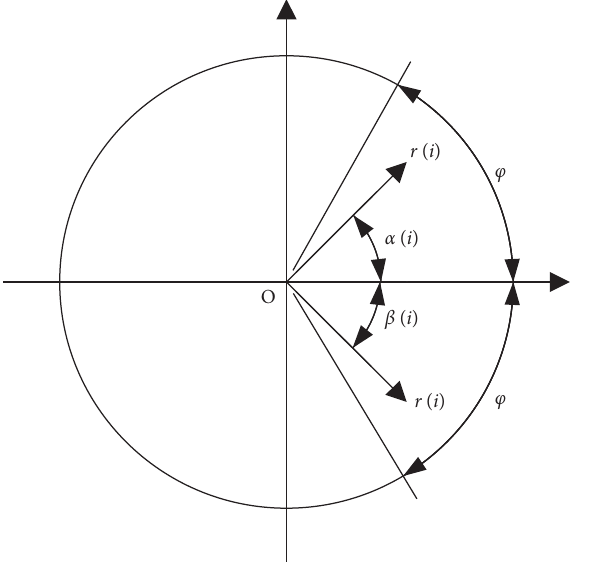
Figure 6: Schematic diagram of symmetric polar coordinate.